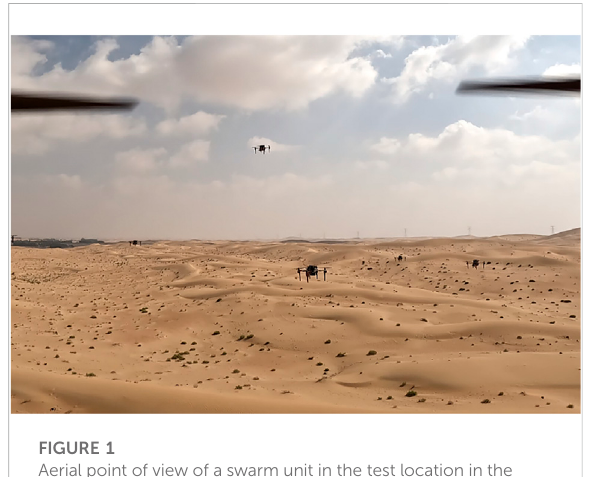
FIGURE 1 Aerial point of view of a swarm unit in the test location in the Abu Dhabi desert during the